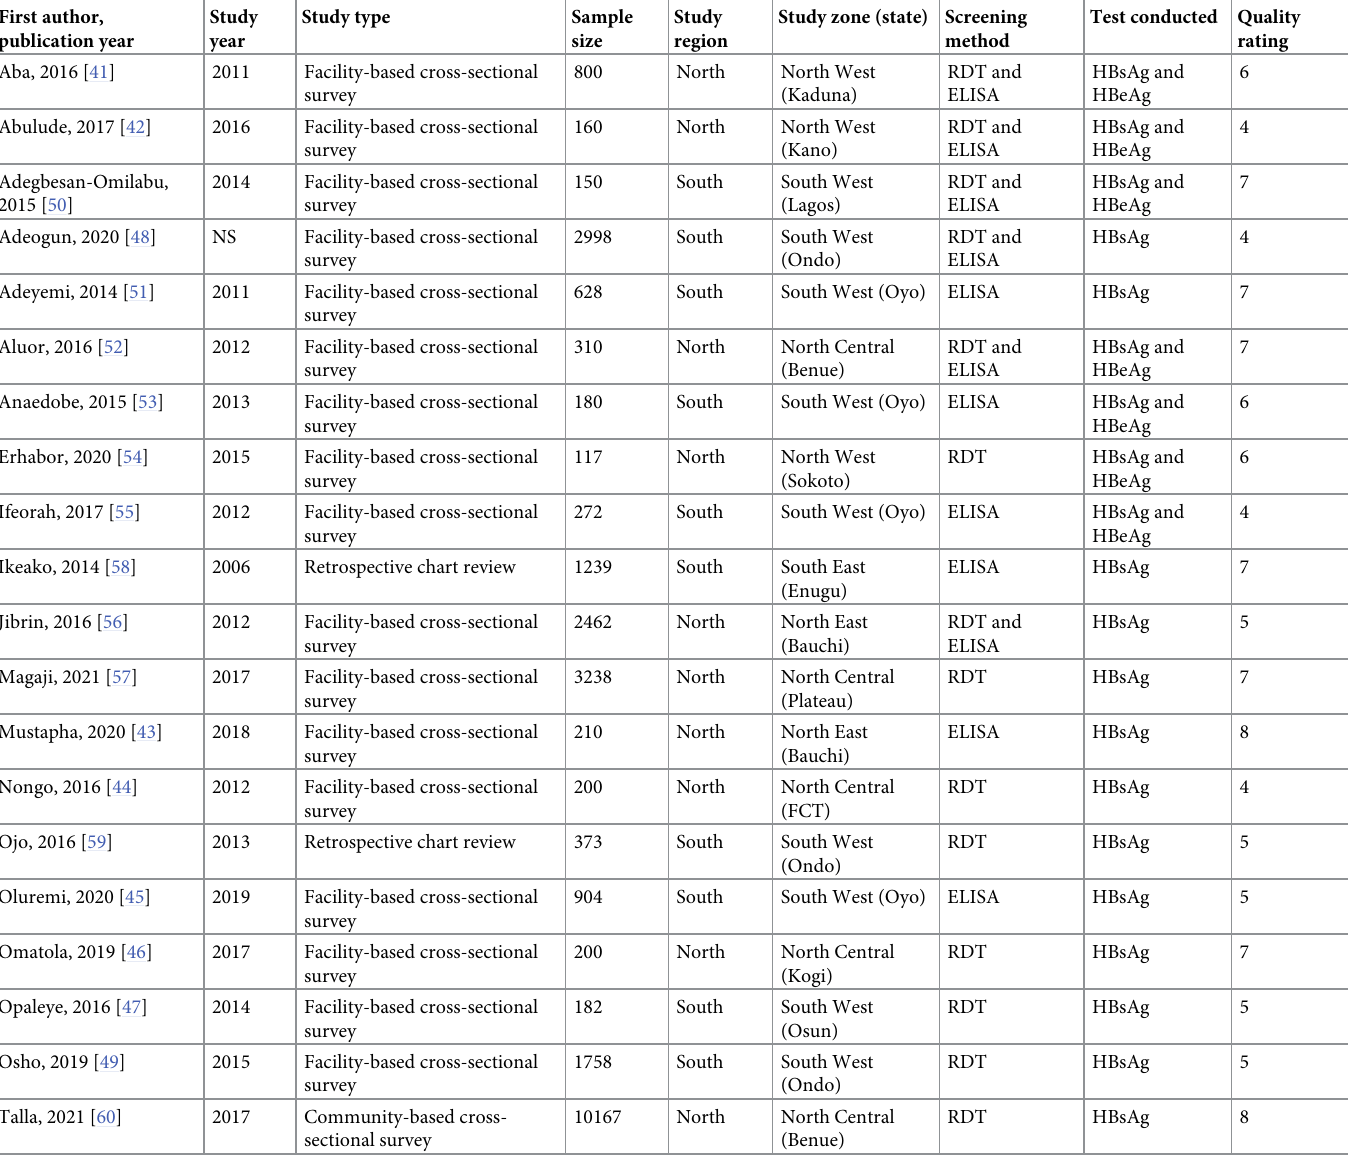
Table 1. Summary characteristics of studies included in the review,